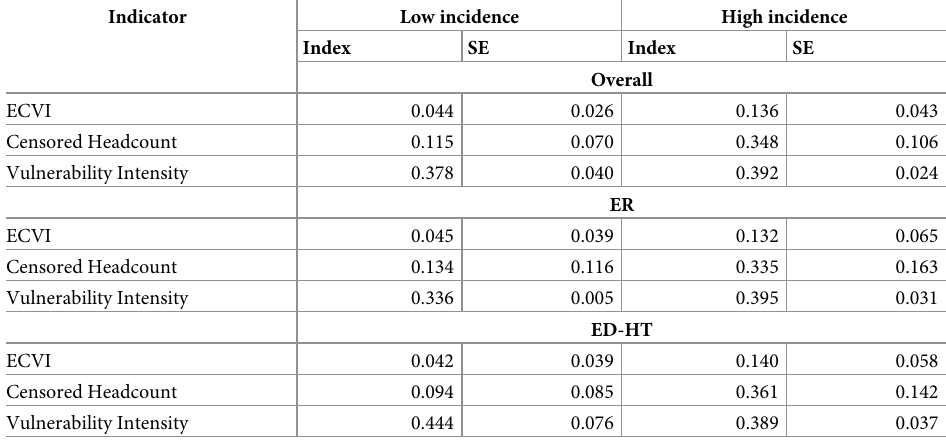
ER: Extreme rain zones in the Brazilian Amazon and Northeast region; ED-HT: Extreme drought and high temperature in the Brazilian Amazon and Northeast region; ECVI: Extreme Climate Vulnerability Index; SE: Standard